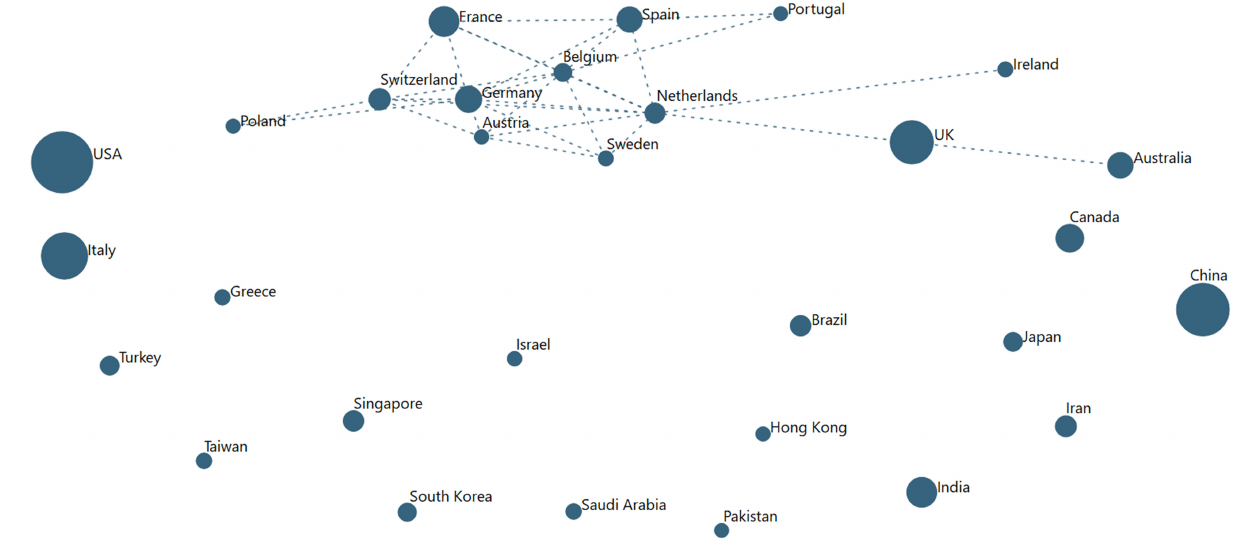
FIGURE 5 | The Extent of Co-authoring among the Top 30 Countries (for COVID-19 papers in 2020). Node size reflects number of papers published, 1949-2020 (to date, July 2); links indicate substantial degree of co-authoring, shown above a